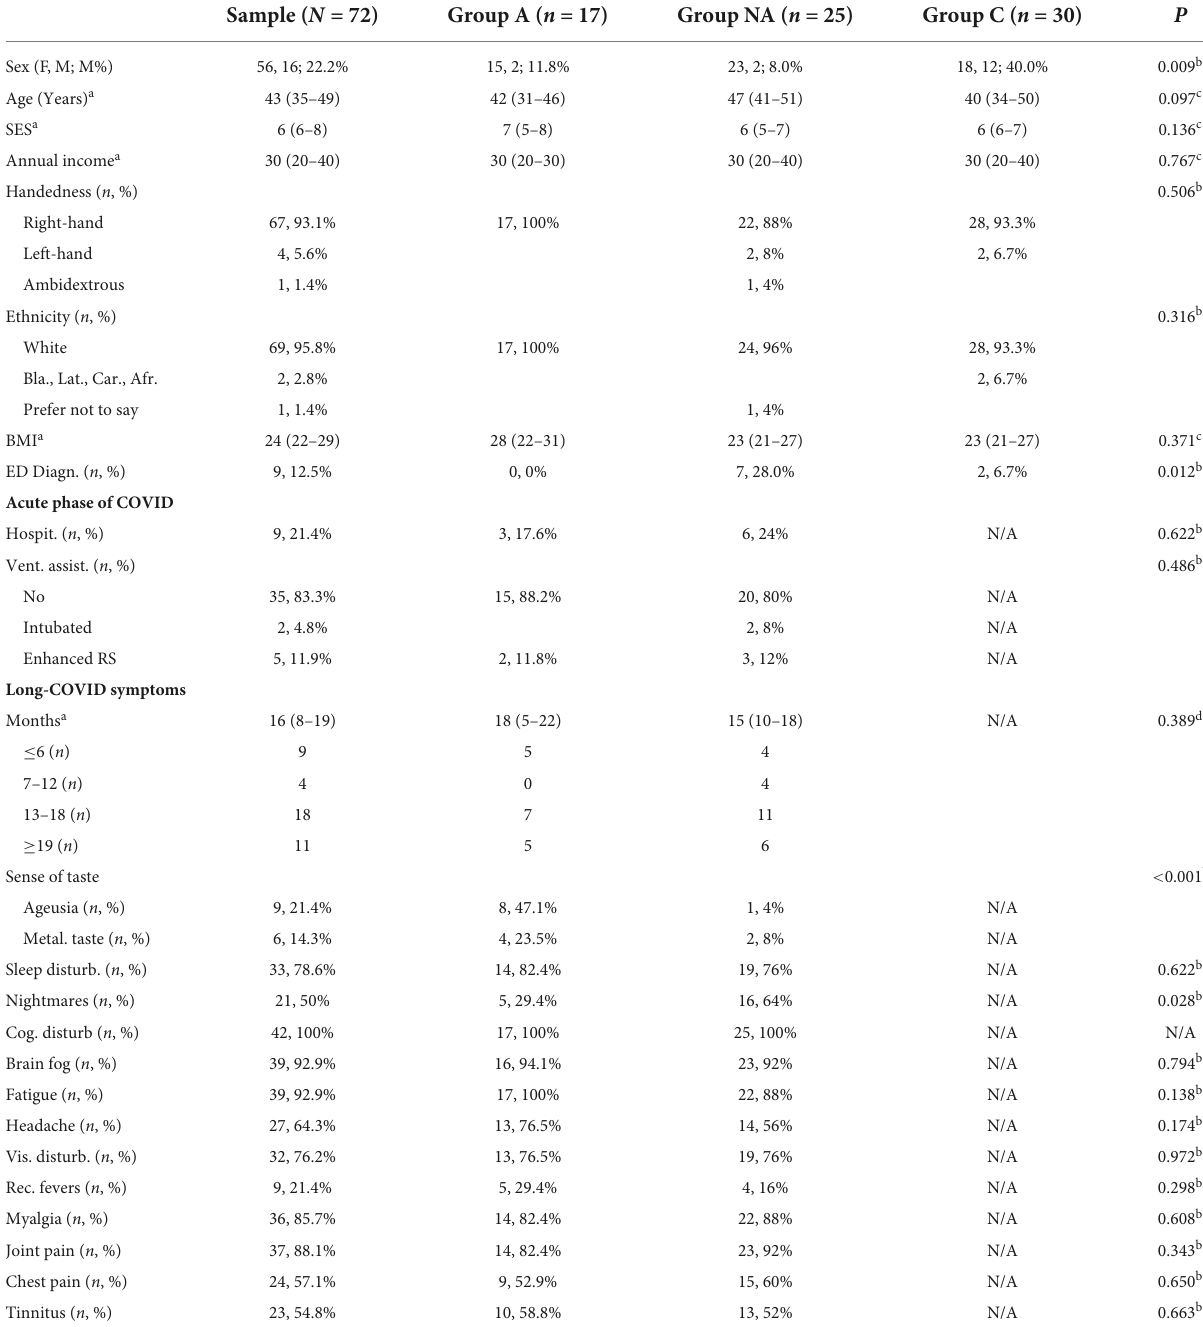
TABLE 1 Demographic information and clinical characteristics of the sample related to the COVID